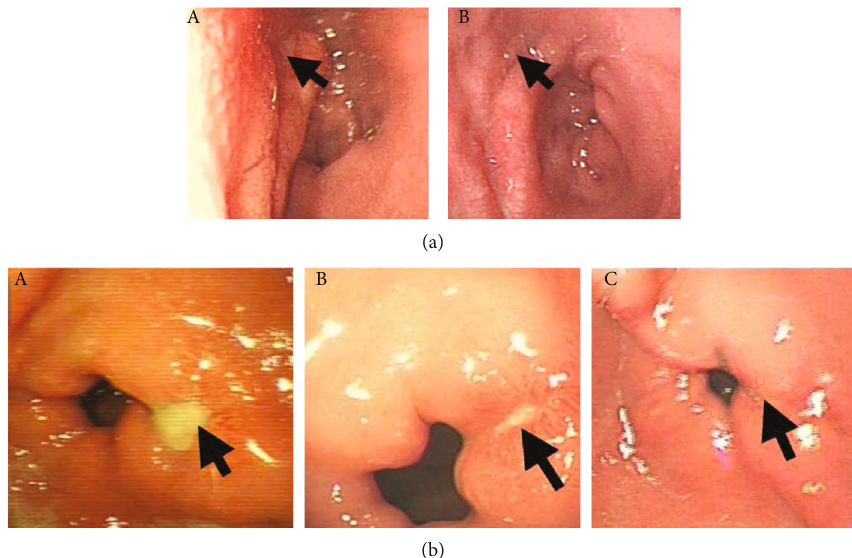
Figure 3: Observation for aPRP therapy for peptic ulcer. (a) A 46-year-old female patient had an 8mm duodenal ulcer and received the combination therapy of aPRP and rabeprazole. (A) Before the treatment. (B) After 10-day treatment. (b) A 35-year-old male patient had an 8mm gastric ulcer and was cured only by rabeprazole. (A) Before the treatment. (B) After 10-day treatment. (C) After 20-day treatment. The arrow shows the ulcer. It can be seen that the gastric mucosa in the PRP group is closer to the normal gastric mucosa after treatment, while the scar tissue fi lling in the control group is more